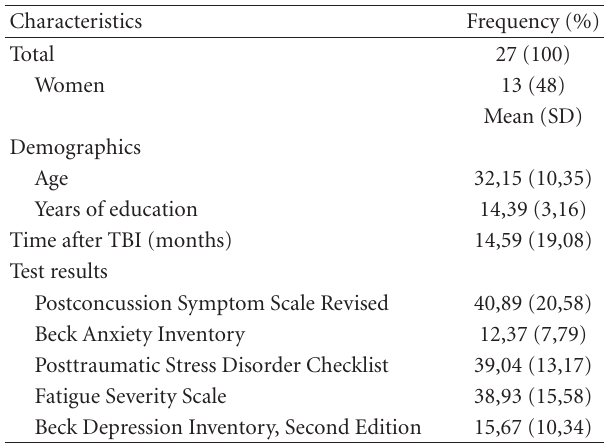
Table 1: Demographic and clinical profile of